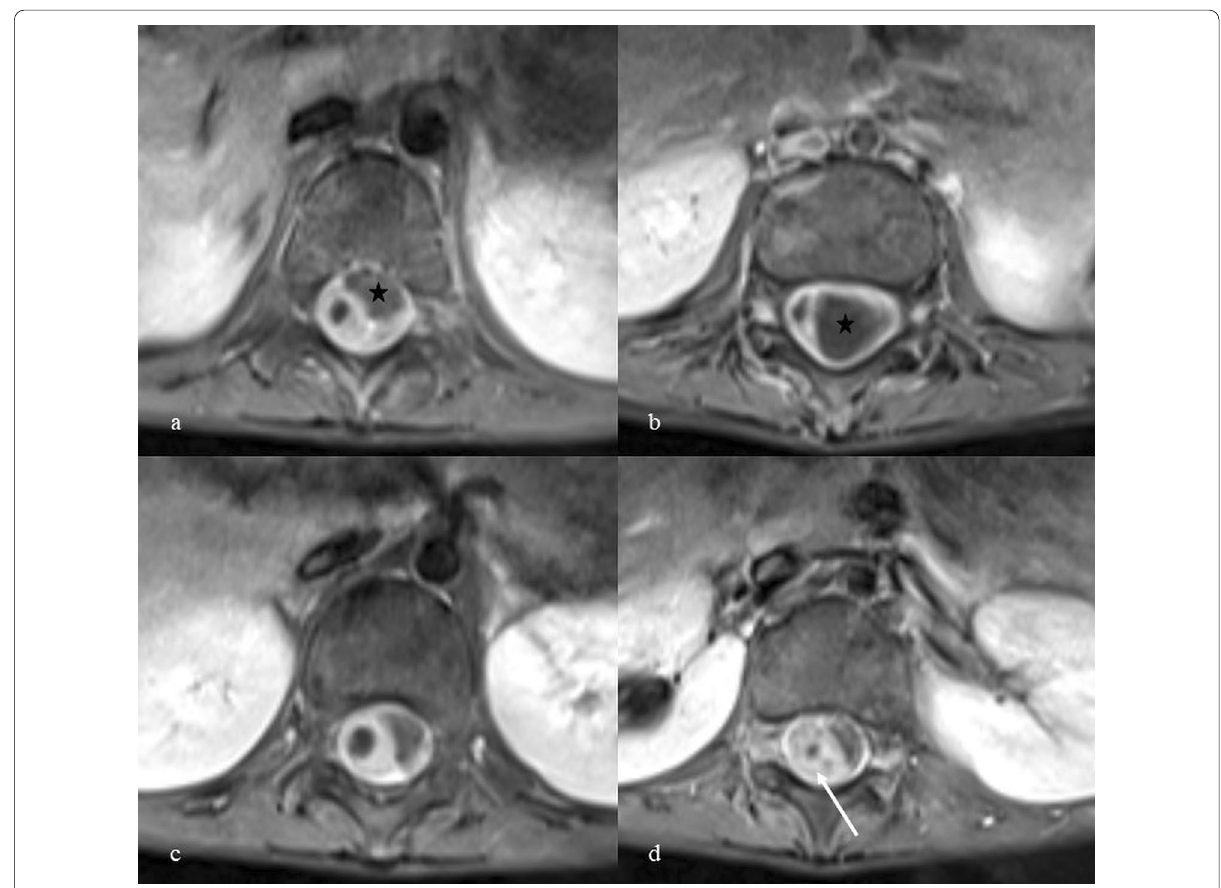
Fig. 4 Axial postcontrast T1 images ( a – d ) of the thoracolumbar spine show enhancing soft tissue thickening (arrow) with septae and non-enhancing areas (asterisk) representing adhesive arachnoiditis with loculated